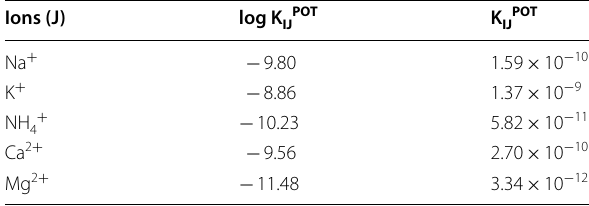
Table 1 Selective coefficients of pH sensors using SSM for primary ion (H + ) against interfering ions